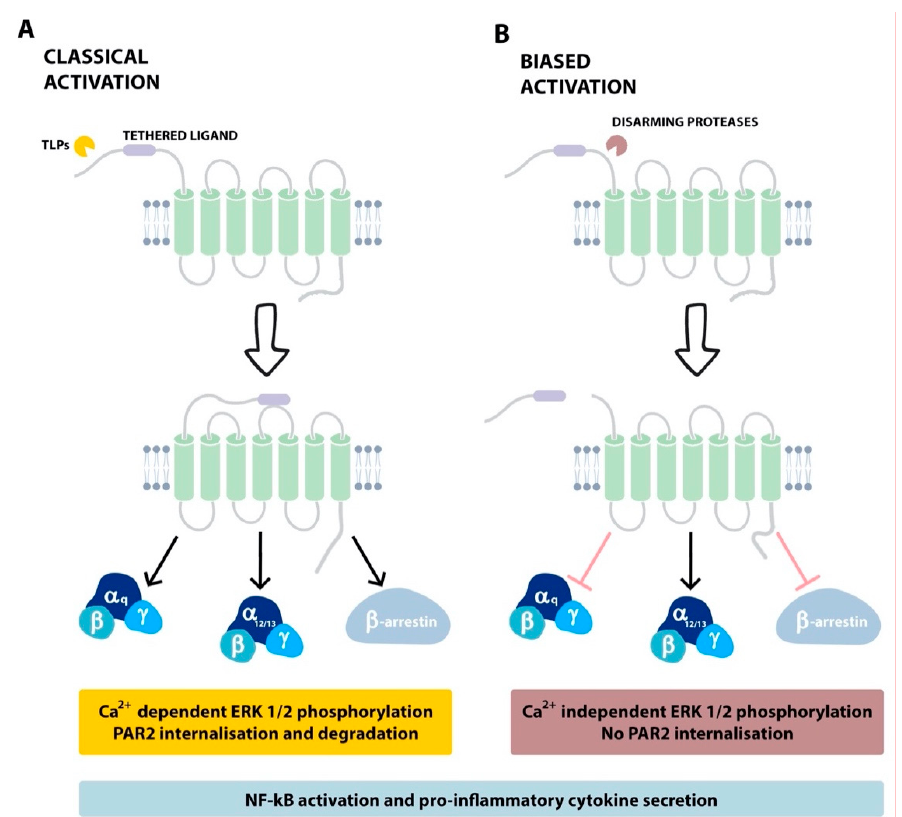
Figure 5. Classical (canonical) and biased (noncanonical) activation of PAR2. ( A ) Classical: Activation of PAR2, through the proteolytic removal of the N-terminal pro-peptide domain by trypsin and TLPs, unmasks the tethered ligand in order to trigger signalling via G α q , and calcium flux leads to associated inflammatory responses. ( B ) Biased: Proteases cleaving downstream of the activation site (e.g., NE and PR-3) disarm the receptor to truncate the tethered ligand, rendering it unavailable for further activation, although the MAPK pathway can still be activated independent of calcium increase and β -arrestin interactions.